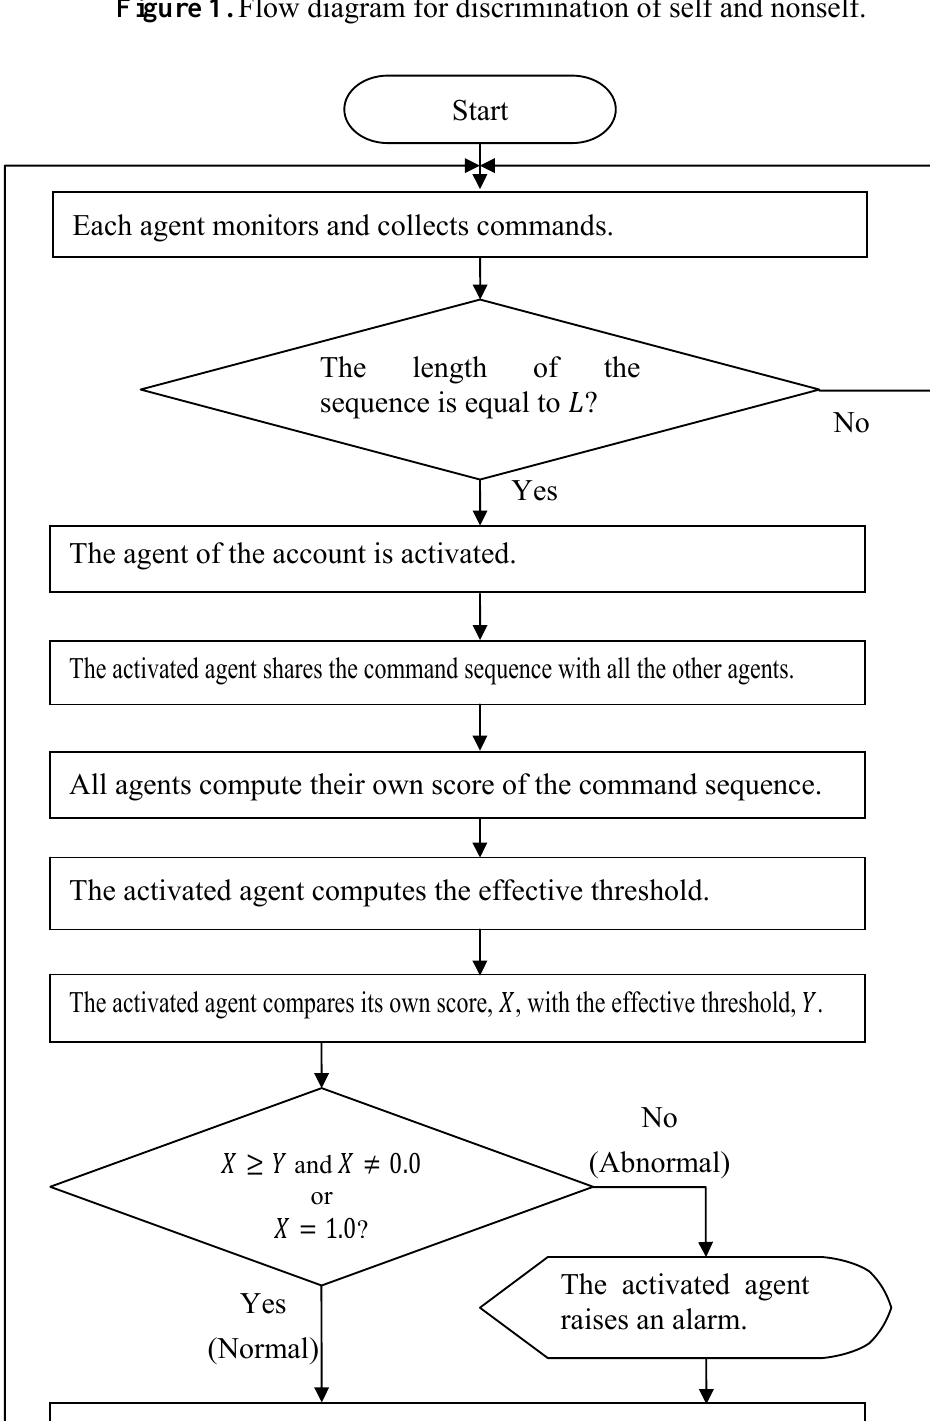
Figure 1. Flow diagram for discrimination of self and